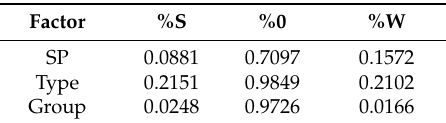
Table 4. ANOVA results ( p -value).